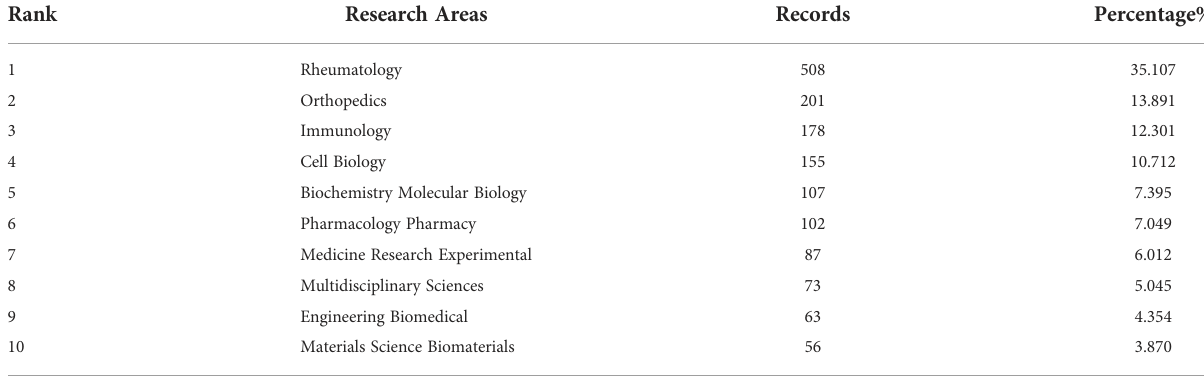
TABLE 3 The top 10 well-represented research areas related to macrophages associated with osteoarthritis. Rank Research Areas Records